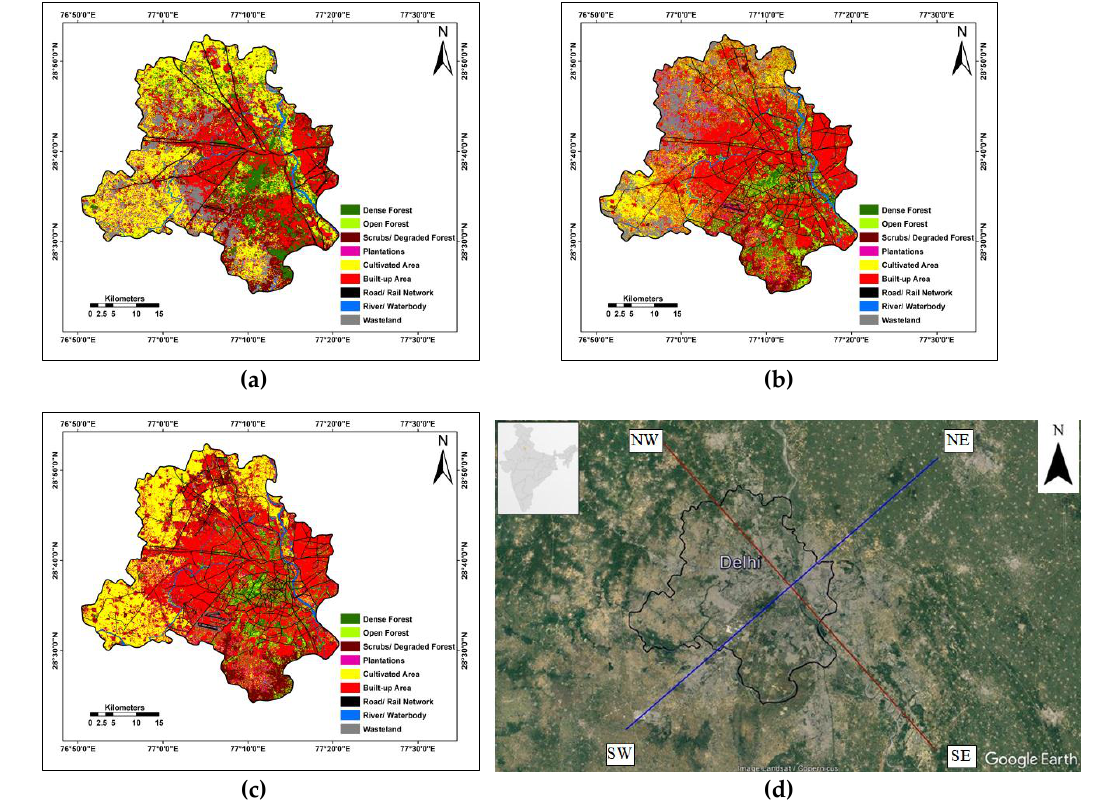
Figure 1. Land use land cover (LULC) maps of Delhi, India [39] for the years ( a ) 1993; ( b ) 2006; and ( c ) 2014; and ( d ) representative Google Earth map showing two 100 km transects in NE-SW (L1, blue line) and NW-SE (L2, red line) directions with central business district i.e., Old Delhi at the centre.